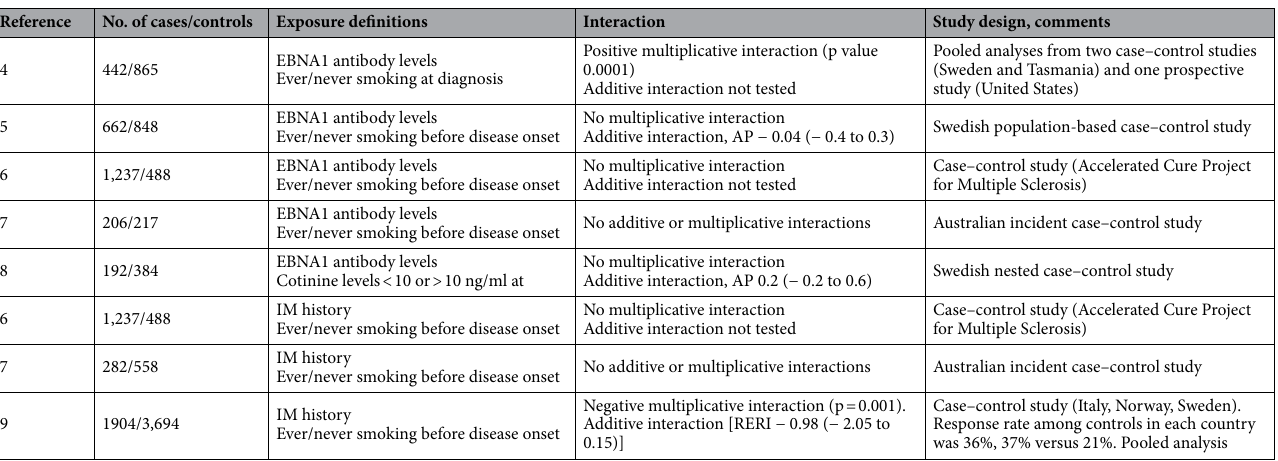
Table 1. Studies on the potential interaction between smoking and measures of